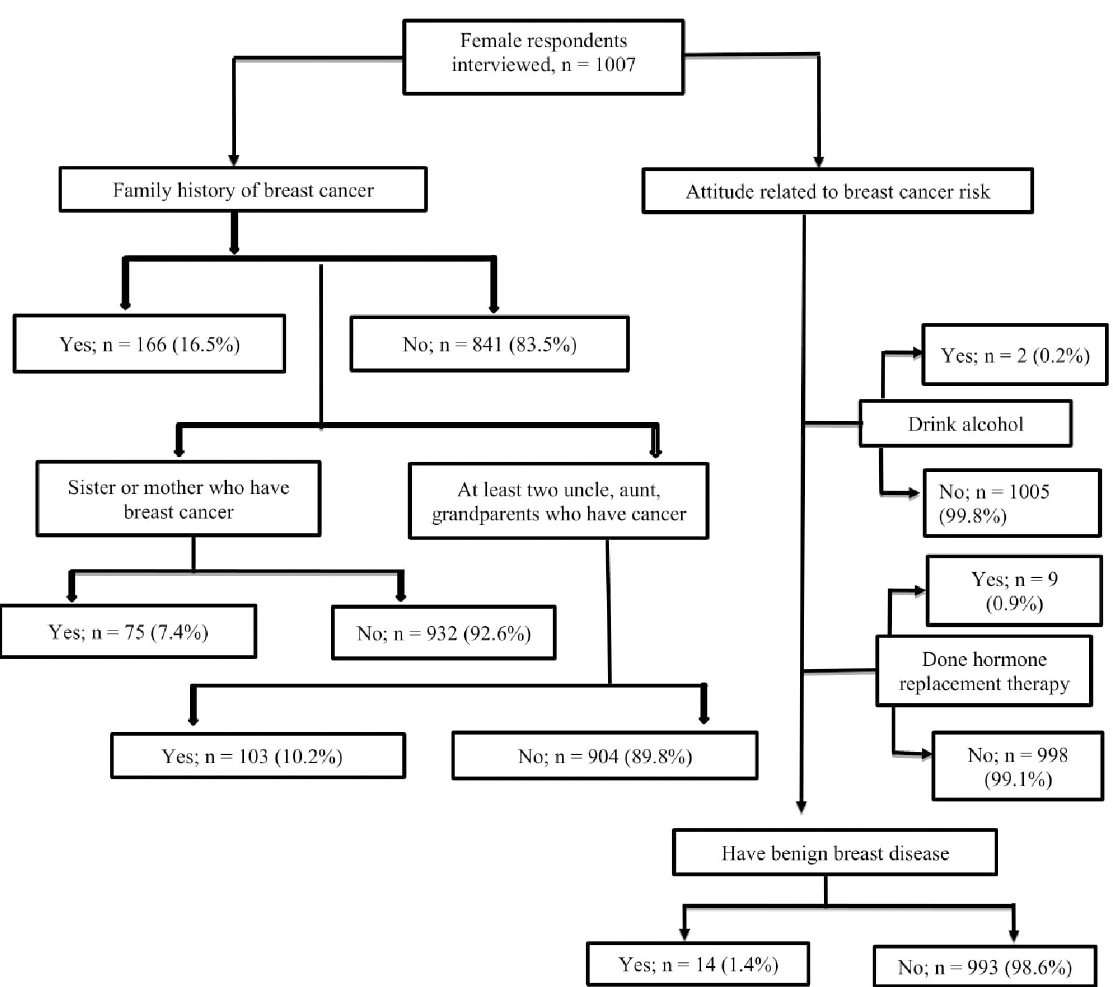
Fig 2. Family history and attitude related to breast cancer of female respondents